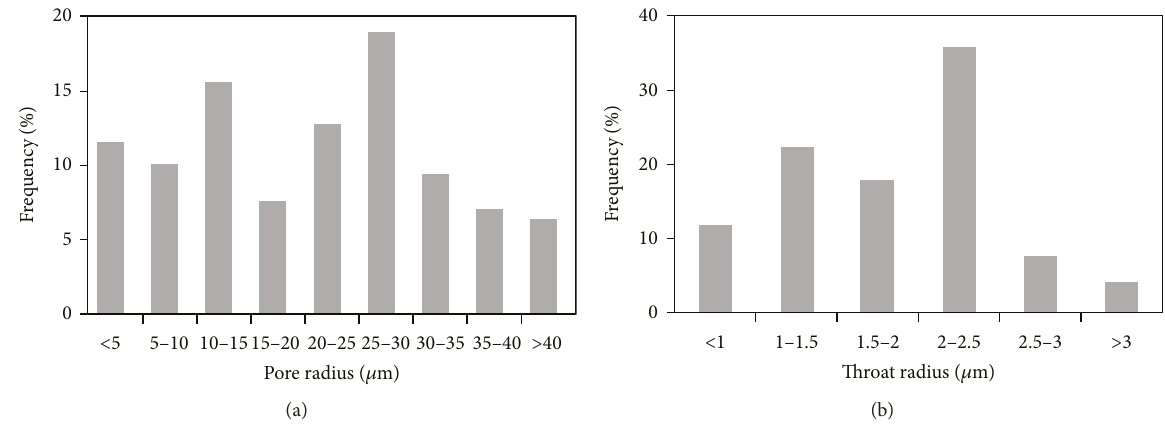
Figure 11: (a) Pore; (b) throat radius distribution of the core sample.